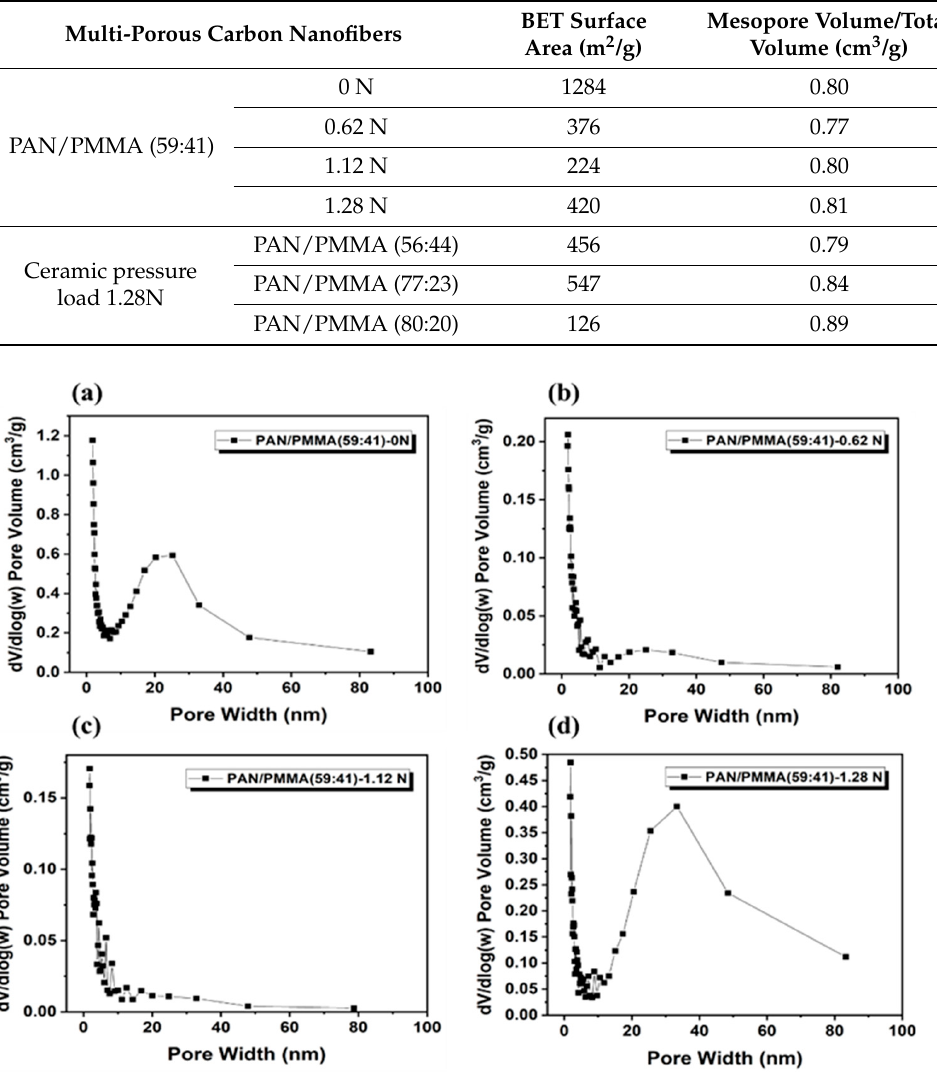
Figure 5. BJH analysis of nitrogen physisorption showing the pore volume distribution with ceramic pressure load: ( a ) 0 N; ( b ) 0.62 N; ( c ) 1.12 N; ( d ) 1.28 N.